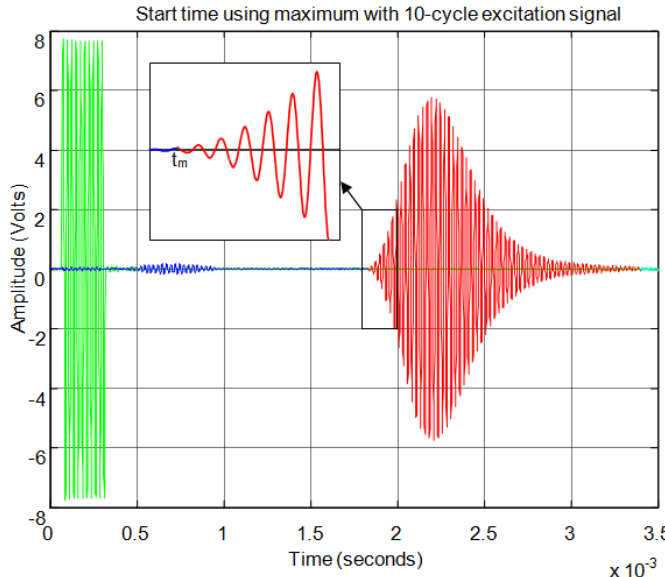
Figure 15. Start time of the echo using maximum.